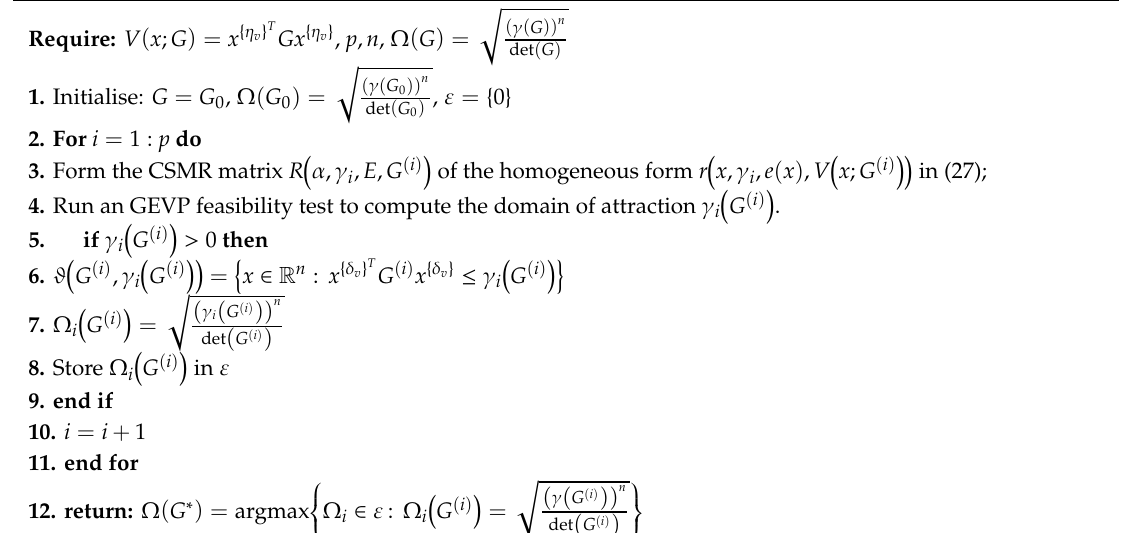
Algorithm 1 Evaluation of the fitness